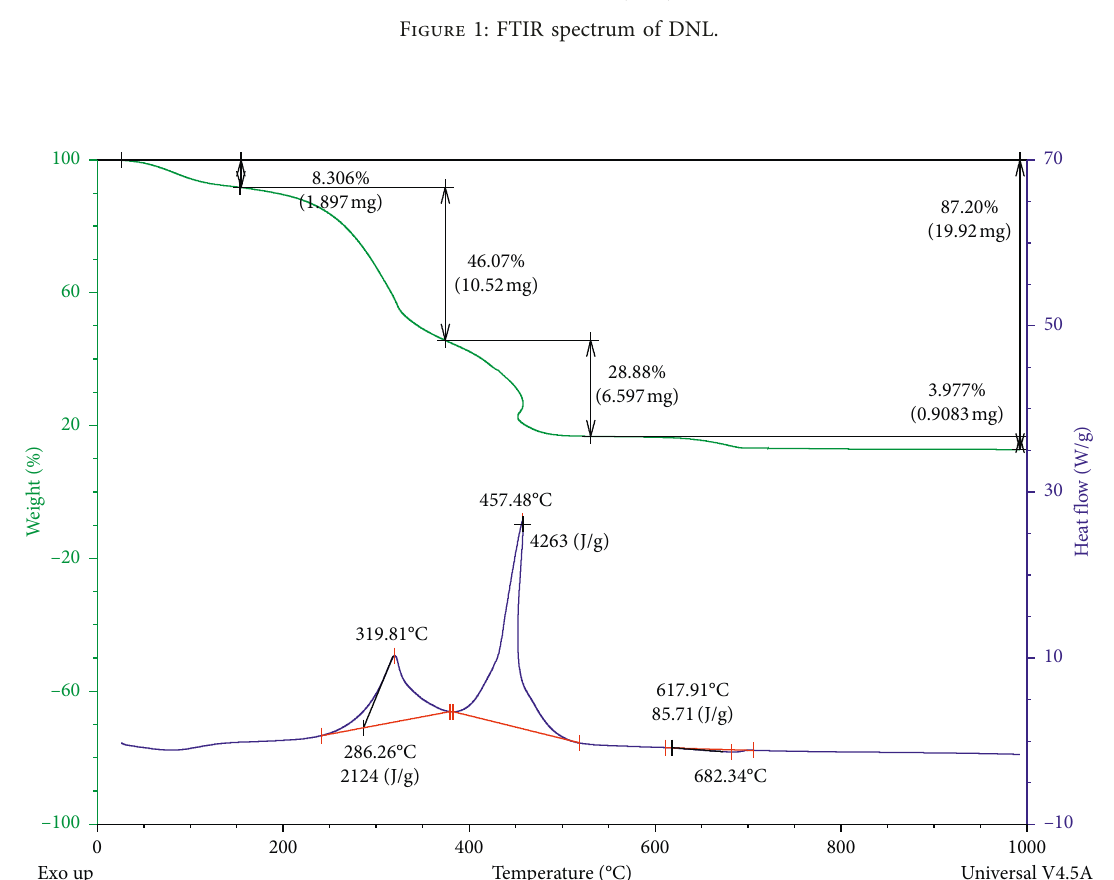
Figure 1: FTIR spectrum of DNL.